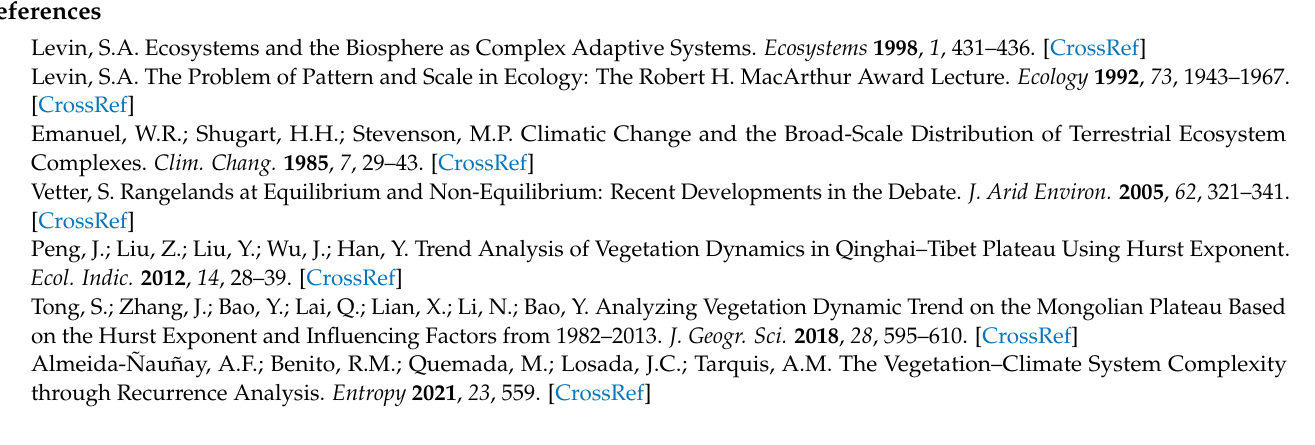
Figure A6. Comparison of the clustering results for URF using HI ( a ) and H2 ( b ) in the agricultural region of Los Vélez (Almería). Cluster 1 is pink, cluster 2 is green, and cluster 3 is blue.